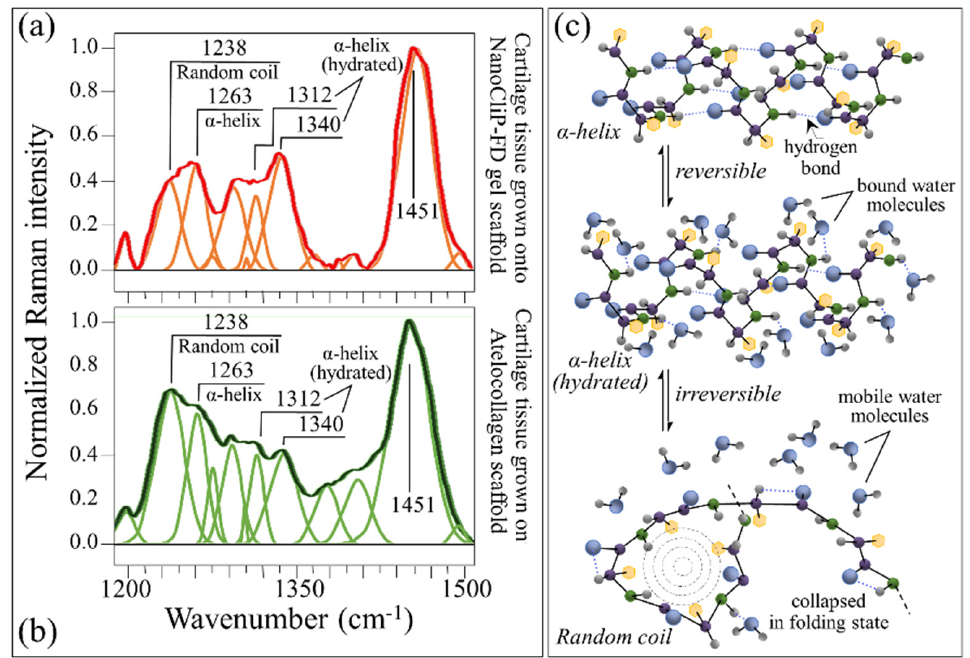
Figure 6. Deconvoluted spectra in the amide III wavenumber region are shown for cartilage tissue grown onto ( a ) NanoCliP-FD gel and ( b ) atelocollagen scaffolds. In ( c ), schematic drafts are given for α -helix, its reversible hydrated configuration, and its irreversibly disordered random coil structures (from top to bottom).